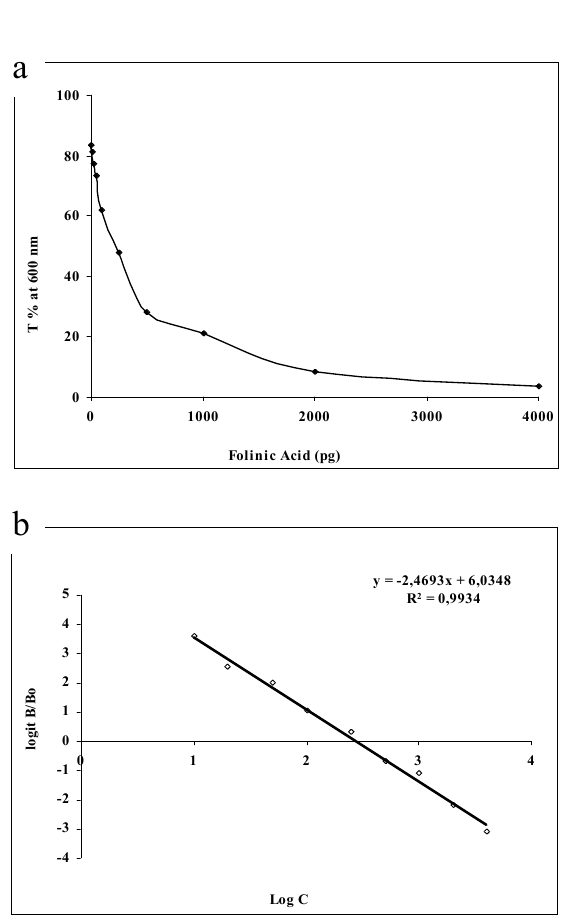
Figure 1. Growth response of folinic acid to L. rham- nosus and a standard curve example (amounts of folin- ic acid were put into assay tubes of 3.9 ml).